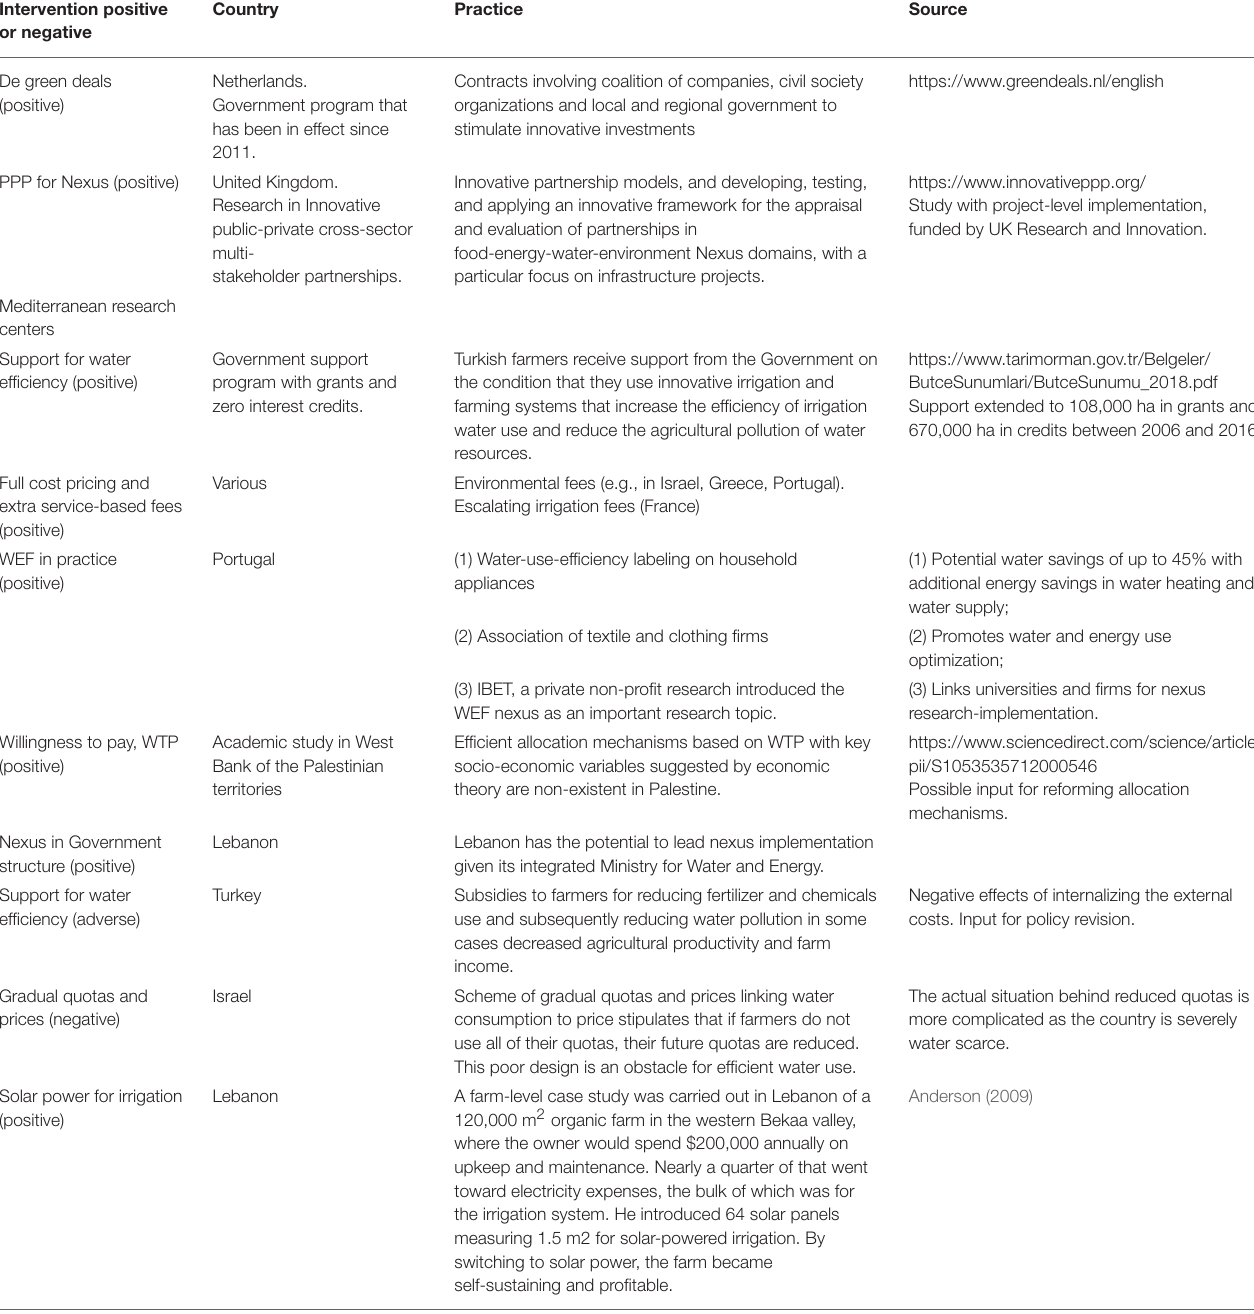
TABLE 2 | Practices with positive and negative/adverse consequences. Intervention positive or